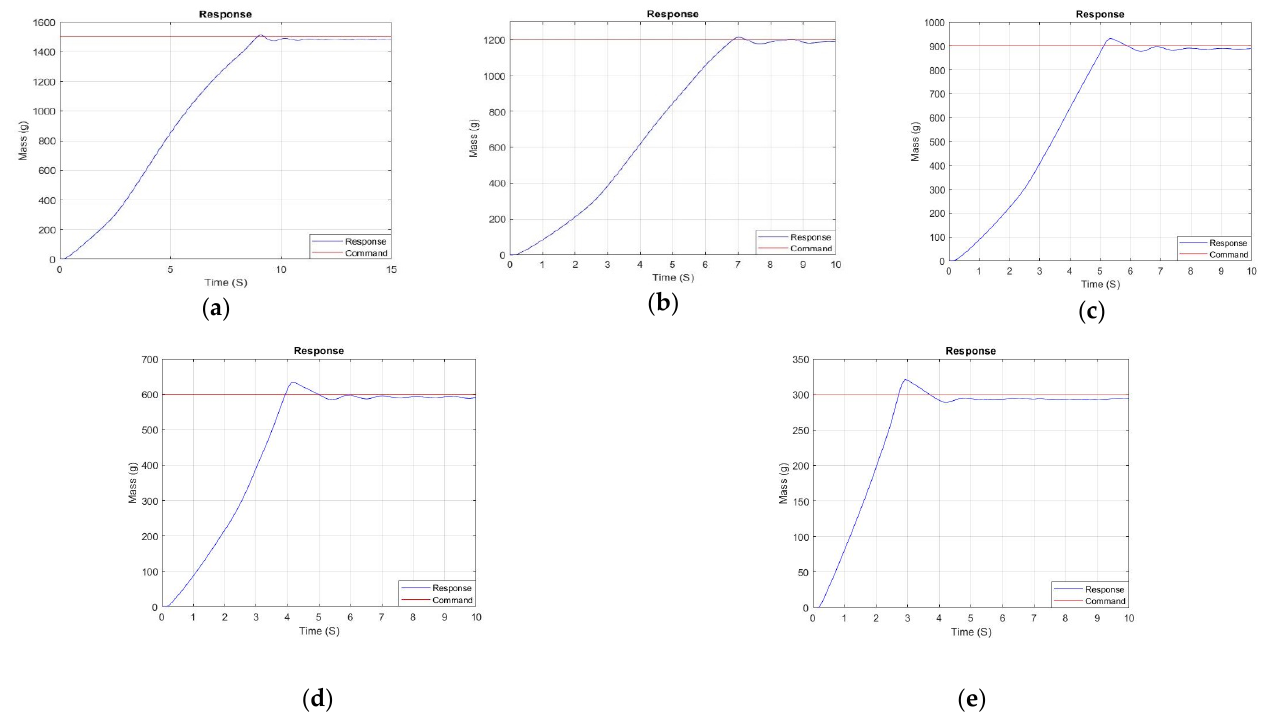
Figure 9. A closed-loop force control of step commands of ( a ) 1500 g, ( b ) 1200 g, ( c ) 900 g, ( d ) 600 g, and ( e ) 300 g.